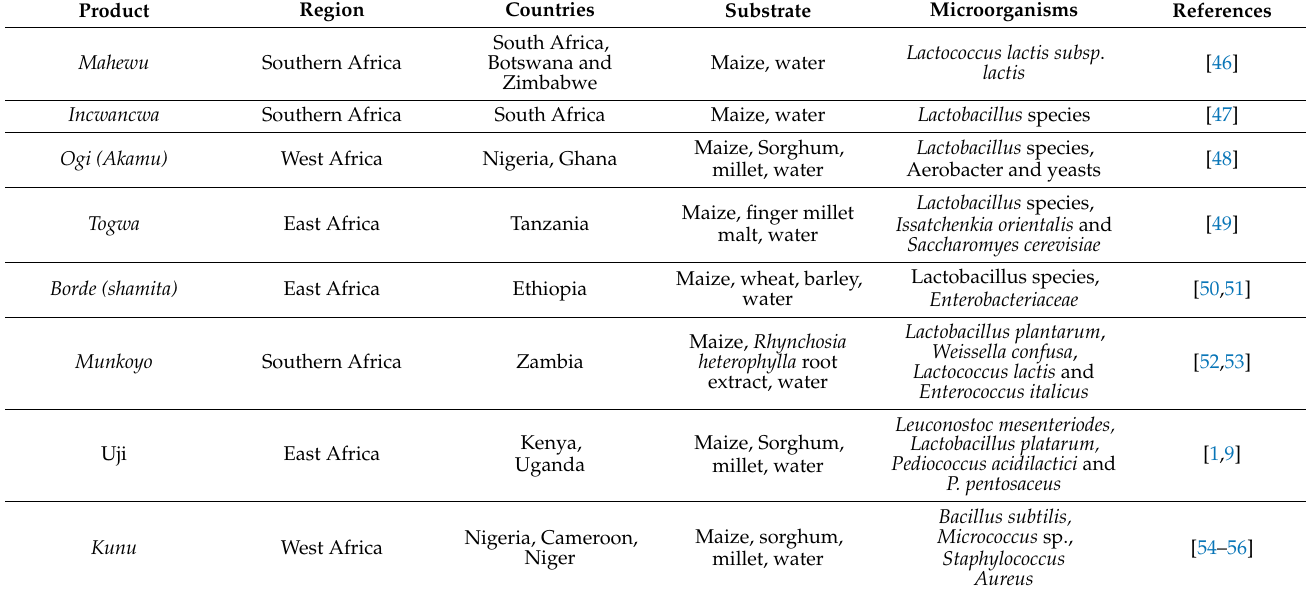
Table 2. Fermented non-alcoholic maize-based gruels and beverages in sub-Saharan